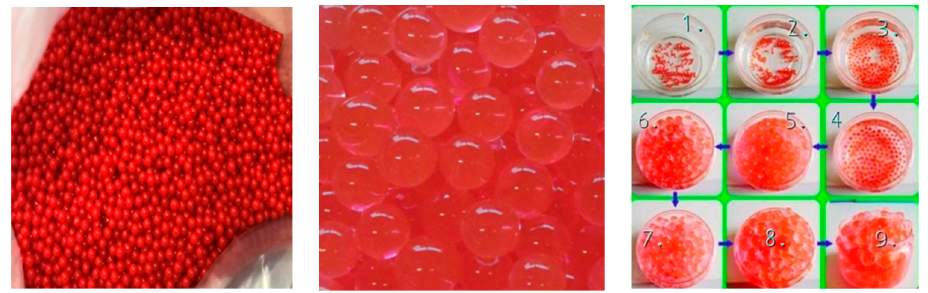
Figure 2. Dry and wet Orbeez (as a drying material).